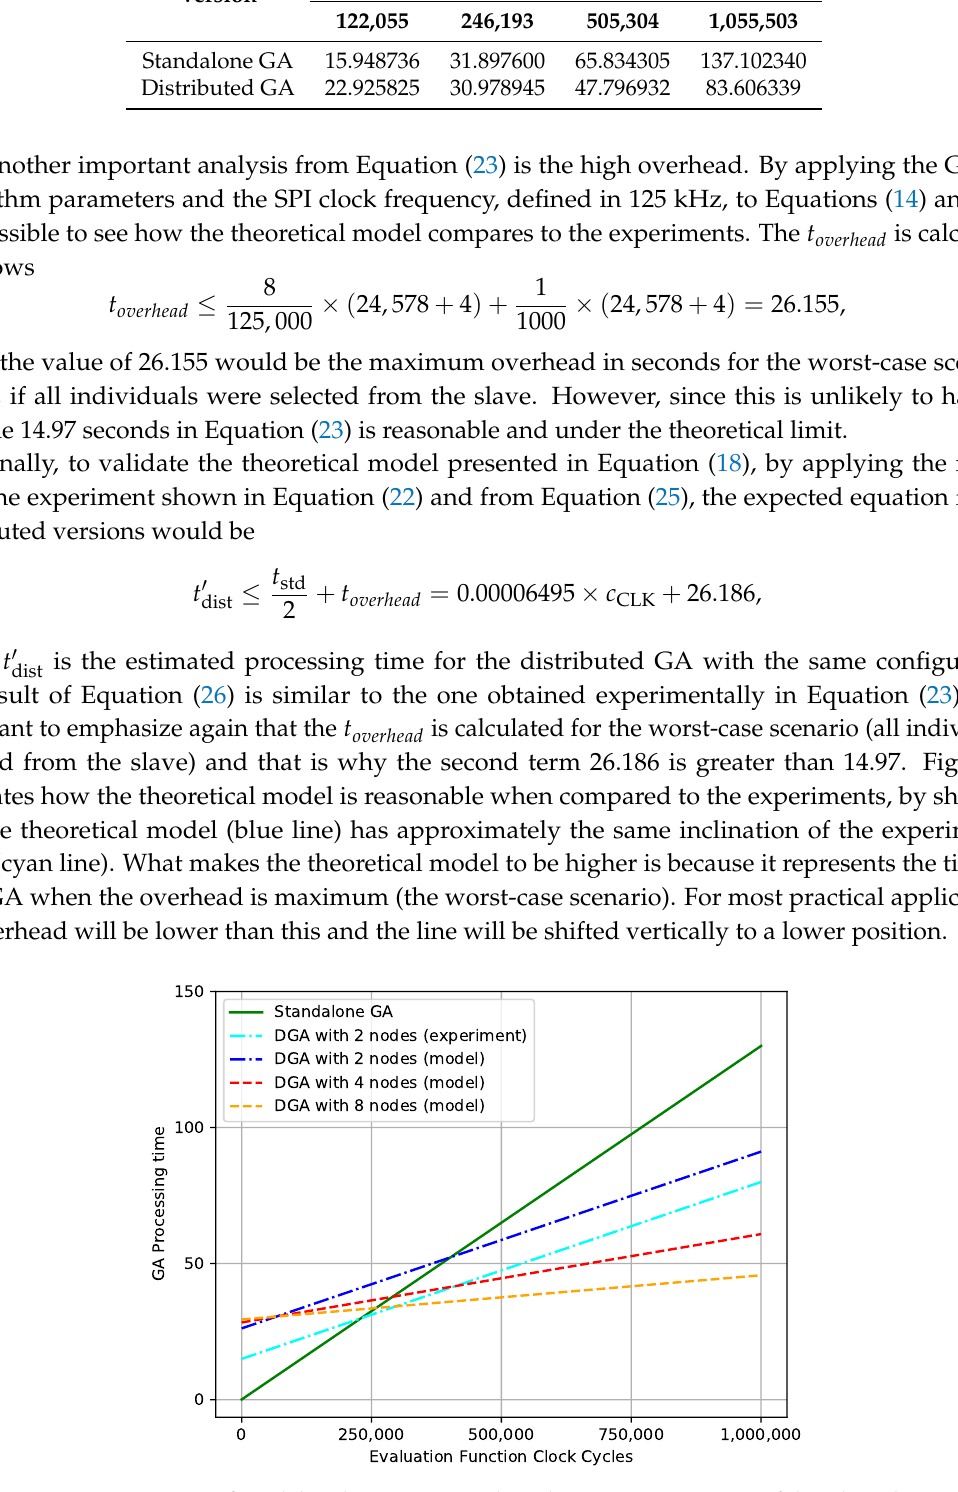
Figure 22. Comparison of model and experiments about how processing time of distributed genetic algorithm (DGA) scales with number of nodes, Q